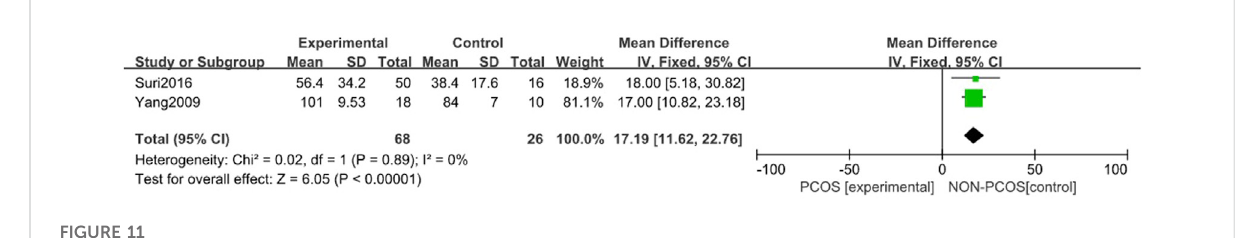
Forest plot of REM sleep correlation between PCOS group and control